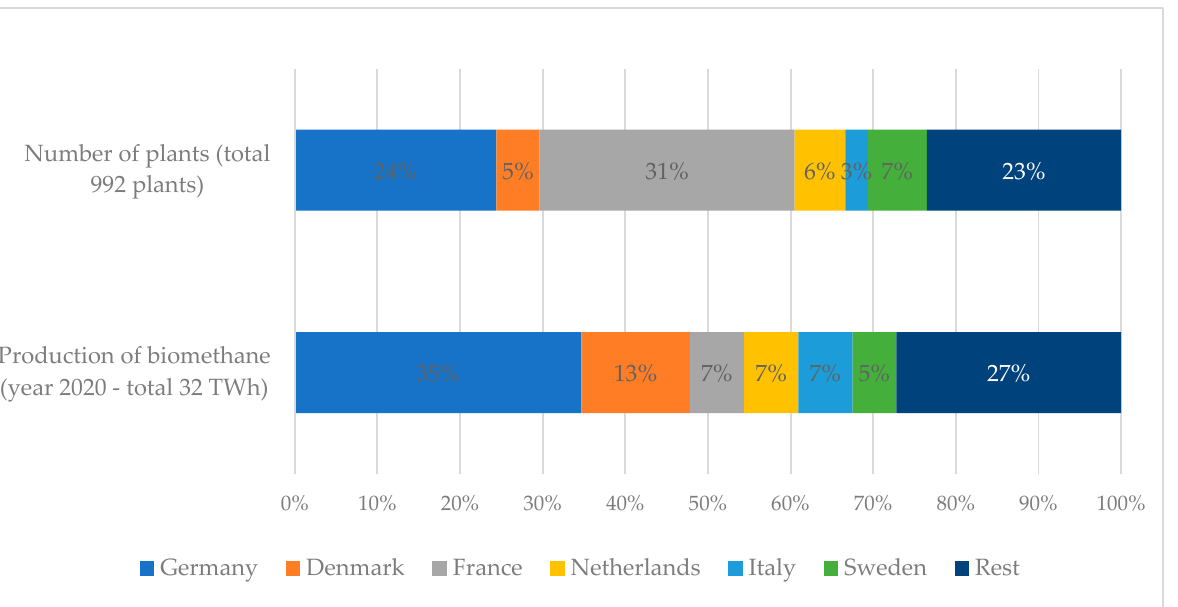
Figure 5. Main producers of biomethane in EU (share in total numbers of biomethane plants and biomethane production). Source: own elaboration based on Jaro et al. [55] and EBA [82].